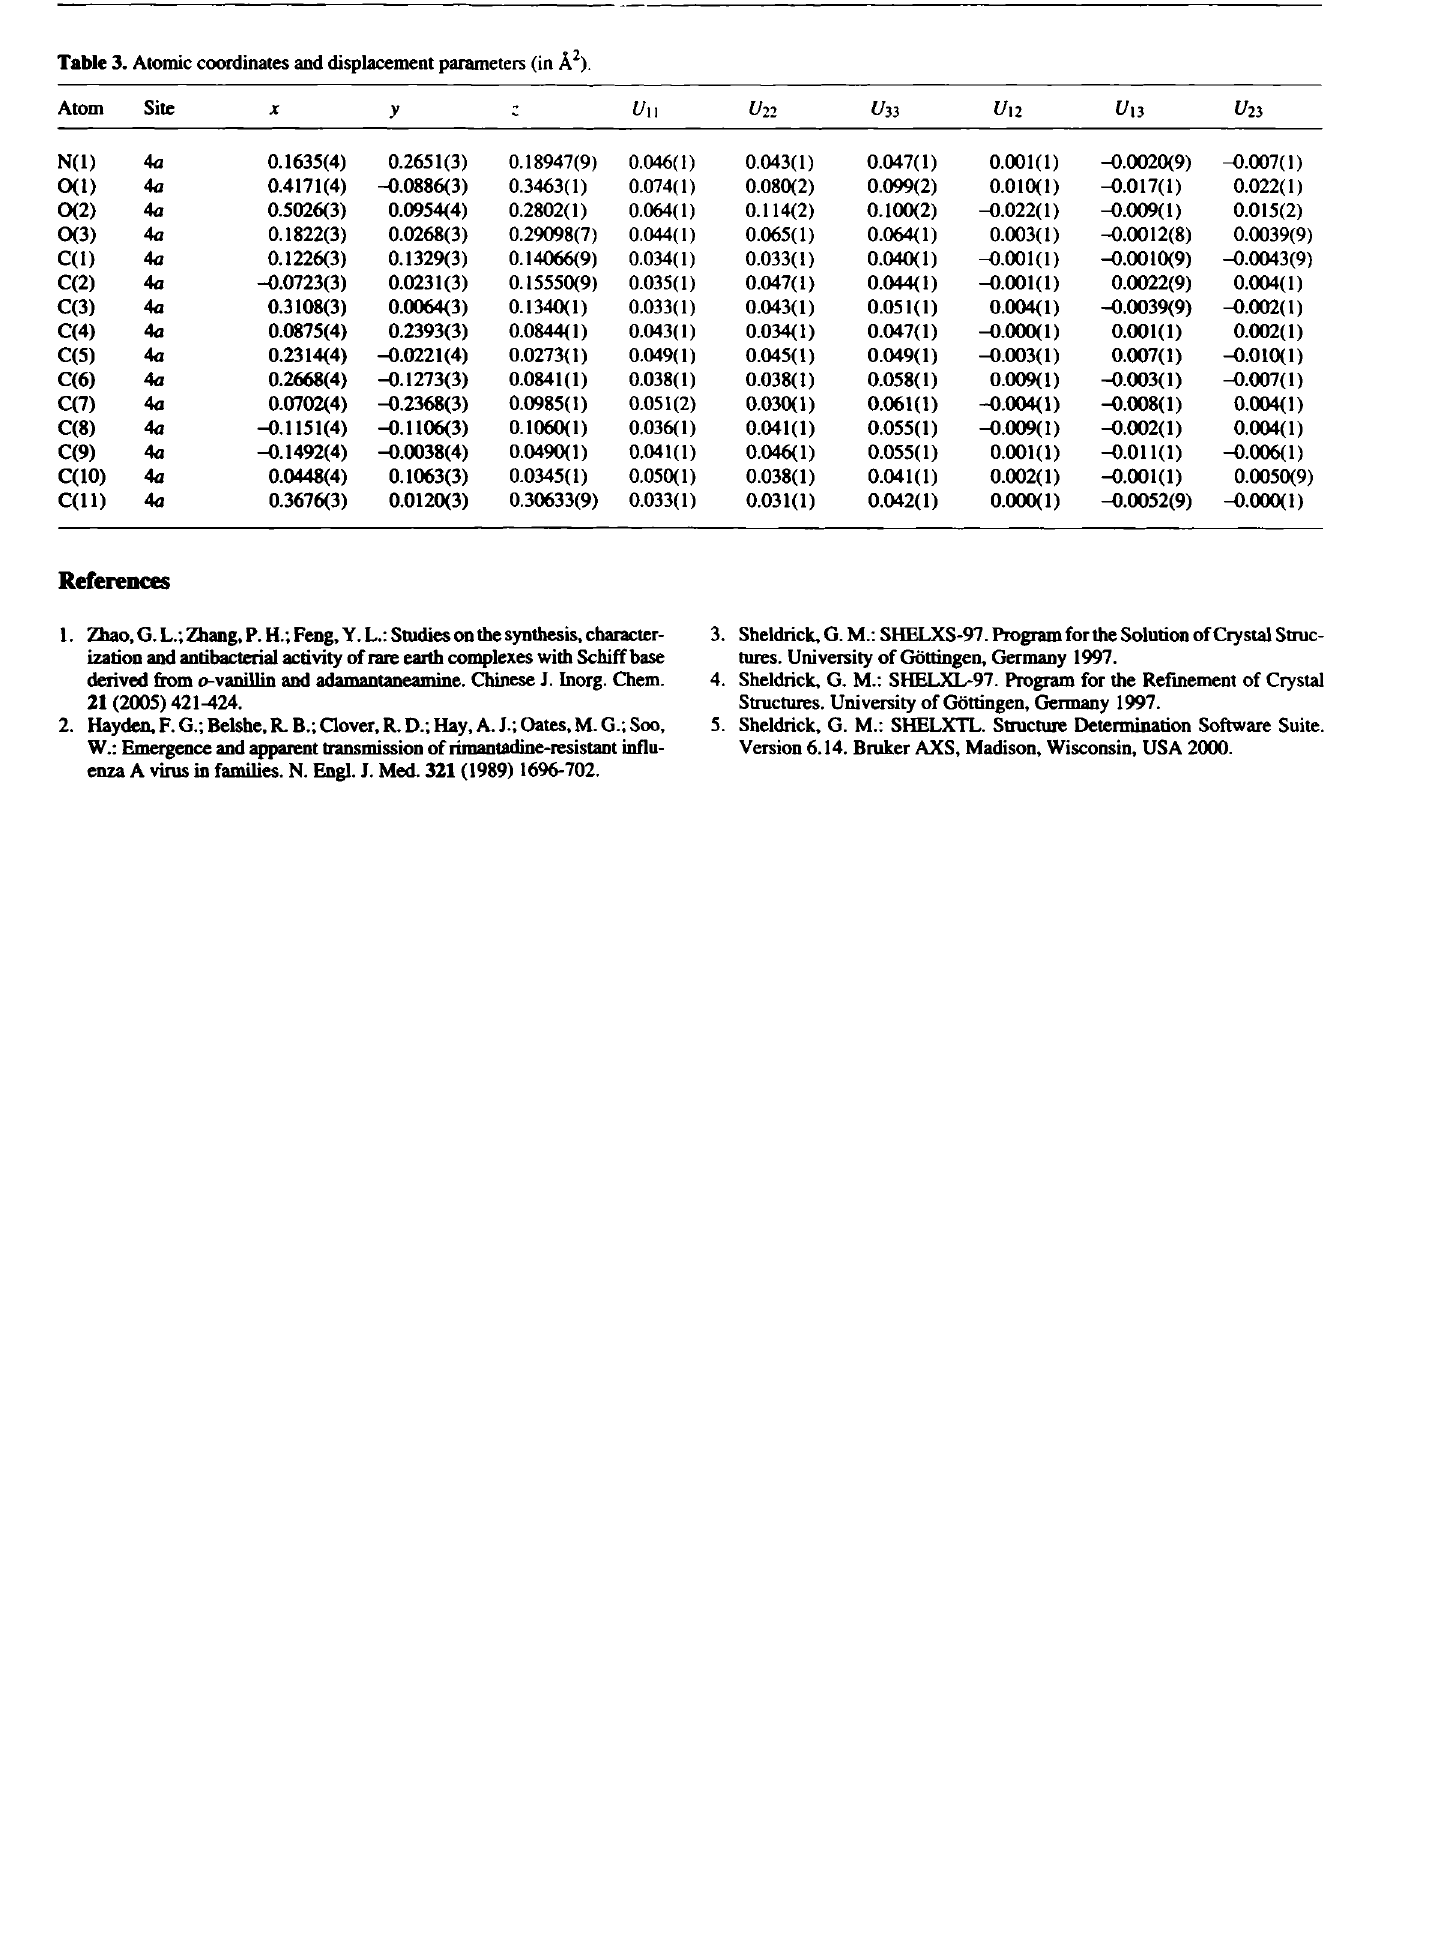
Table 3. Atomic coordinates and displacement parameters (in Â 2